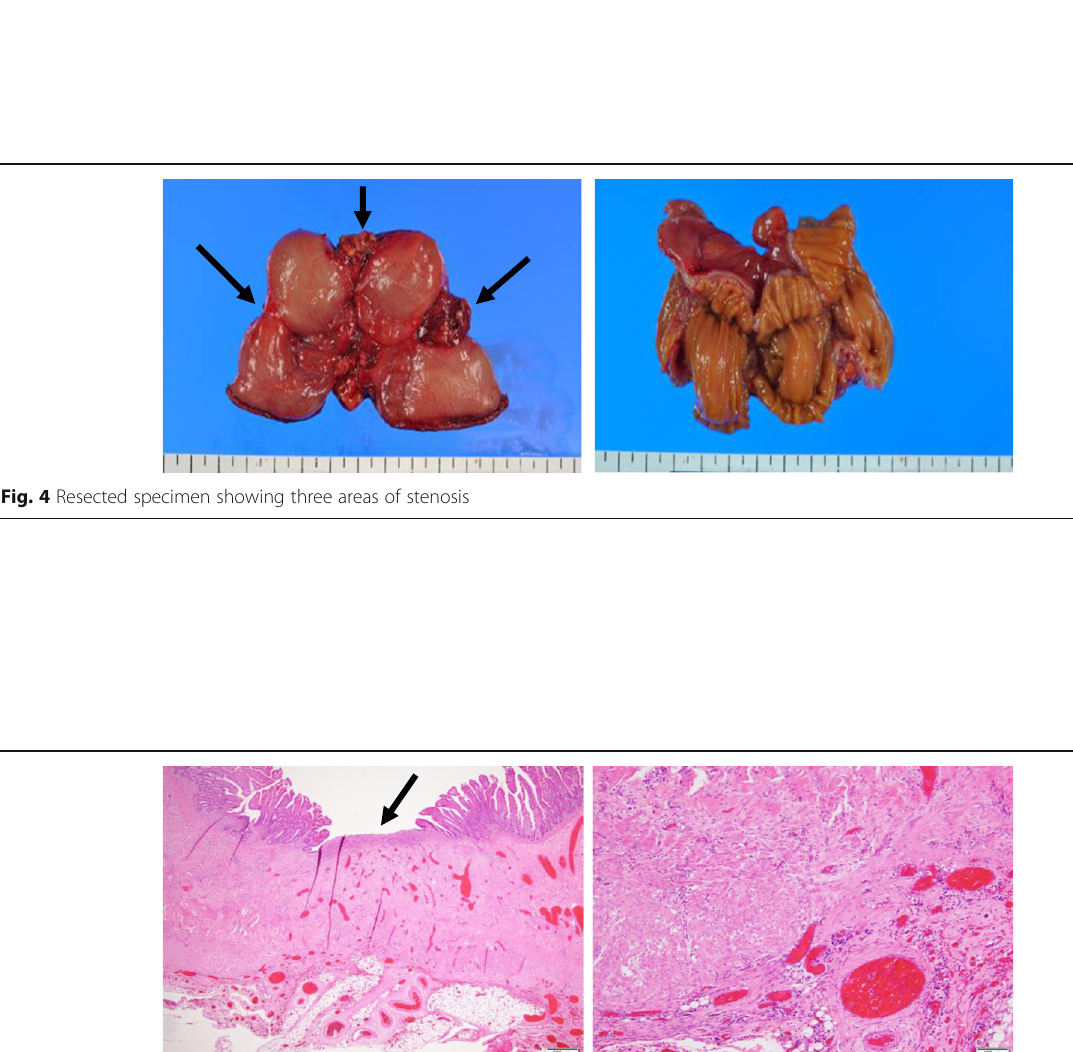
Fig. 5 Histological findings. a Mucosal erosion and ulceration are observed (arrow), and the muscle layer is destroyed and ruptured just below. b Capillary growth and dilatation and fibrosis can be